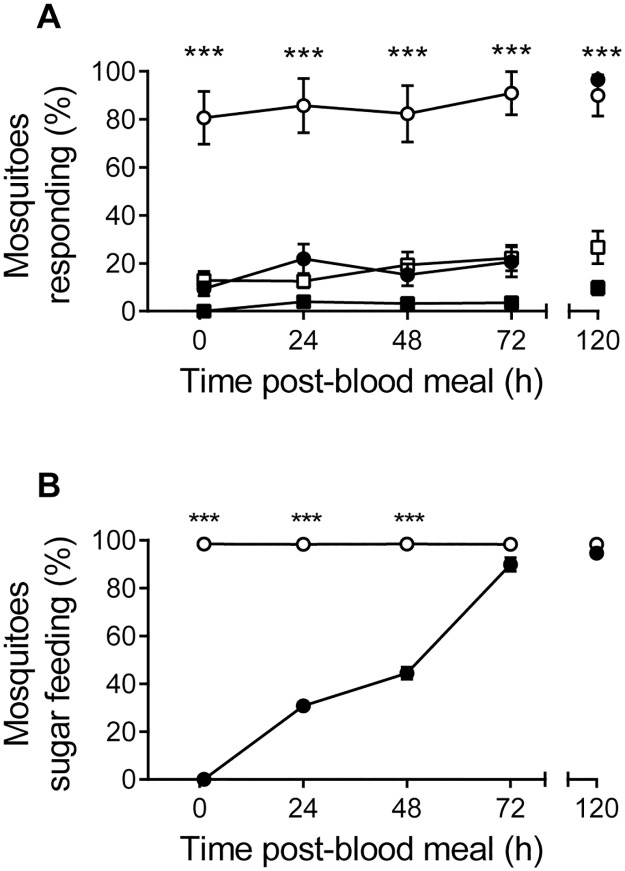
Host-seeking and sugar feeding in female Aedes aegypti after a blood meal.A. Percentage of non-blood fed (white) and blood fed (black) female A. aegypti (n ≈ 30) responding to odors emanating from a human hand (circle) or to a gloved hand as a control (square). Mosquitoes were allowed to lay eggs 96 h post-blood meal. Level of significance for the nominal logistic regression model is shown. B. Percentage of non-blood fed (white) and blood fed (black) female A. aegypti (n ≈ 30–50) taking a sugar meal following a blood meal. Mosquitoes were allowed to lay eggs 96 h post-blood meal. Significant differences between groups were tested using Fisher’s exact test. ***, p < 0.001.